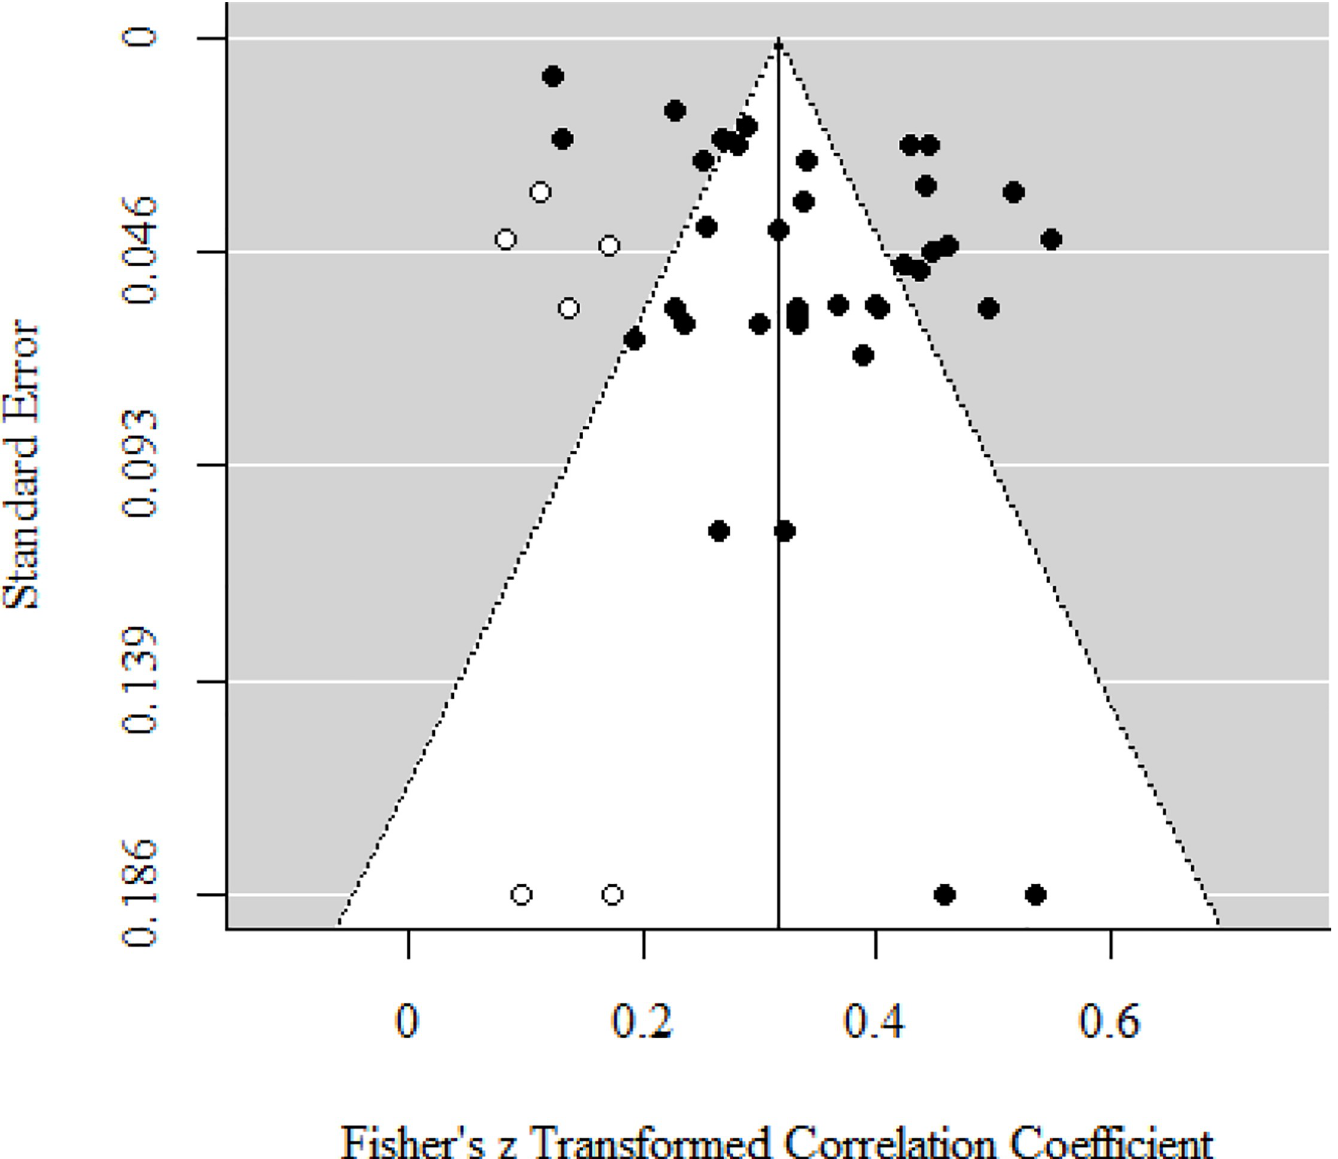
Fig 5. Funnel plot of the relationship between attention and mental health. Black circles: included studies, White circles: added possible missing studies using Trim and Fill methods.